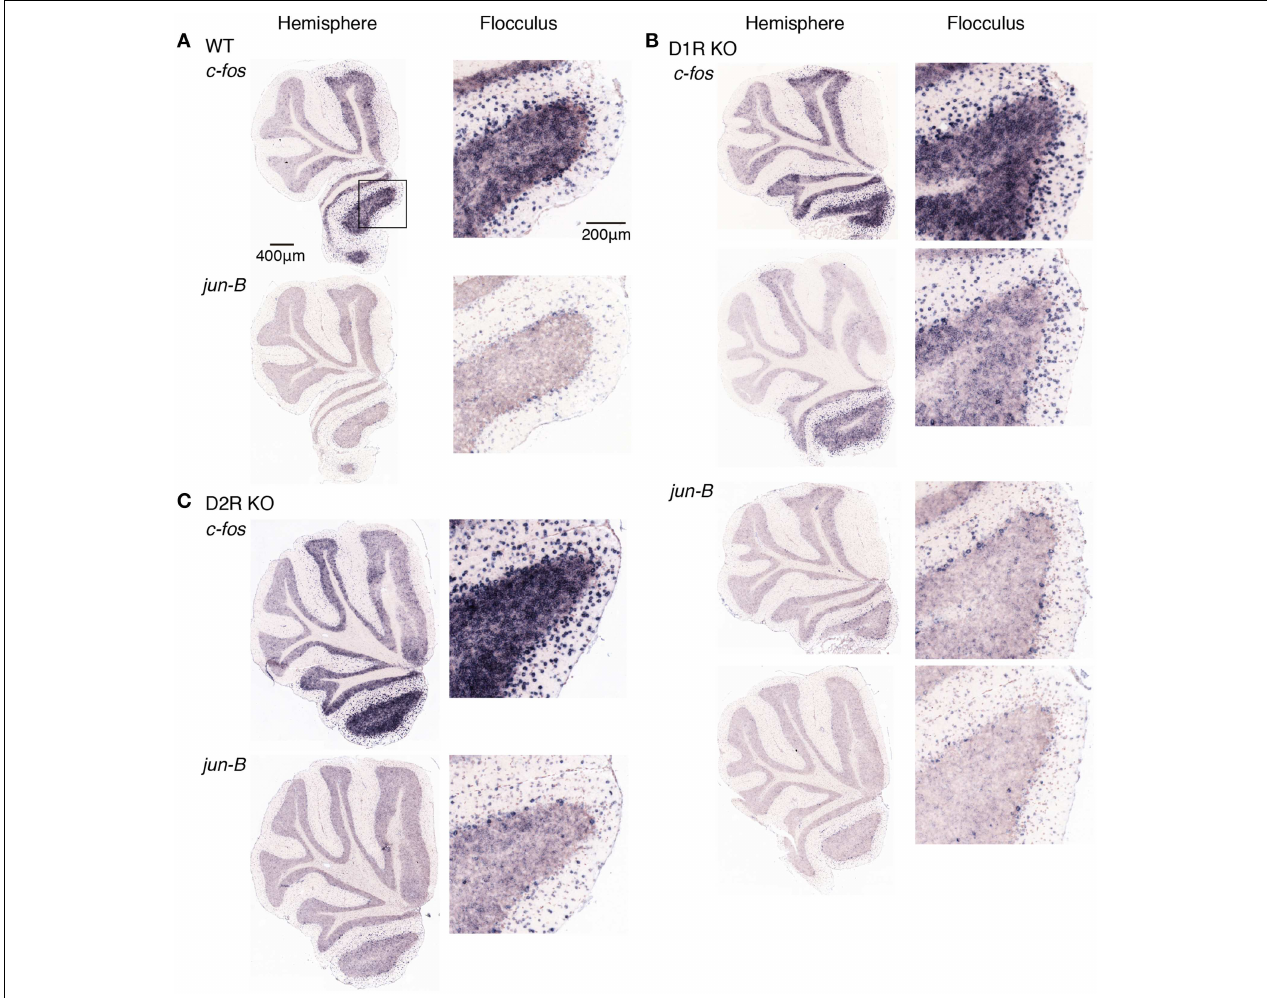
FIGURE 9 | Expression patterns of c-fos and jun-B mRNAs in the cerebellum of trained mice after rota-rod task on day 1. (A) WT, (B) D1R KO, and (C) D2R KO mice were trained to perform a series of rota-rod and Step-Wheel tasks. After the presessions (0rpm, 3 days), the mice performed rota-rod tasks (5rpm) and were sacrificed 30min after the session on the day 1. The left panels show the sections from the hemisphere, the right panels show magnified images of the part enclosed in a box in the first